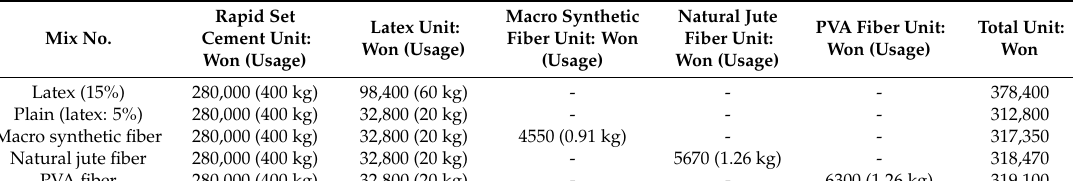
Table 8. Comparing the costs of the material mixtures for repairing pavement. Mix No.